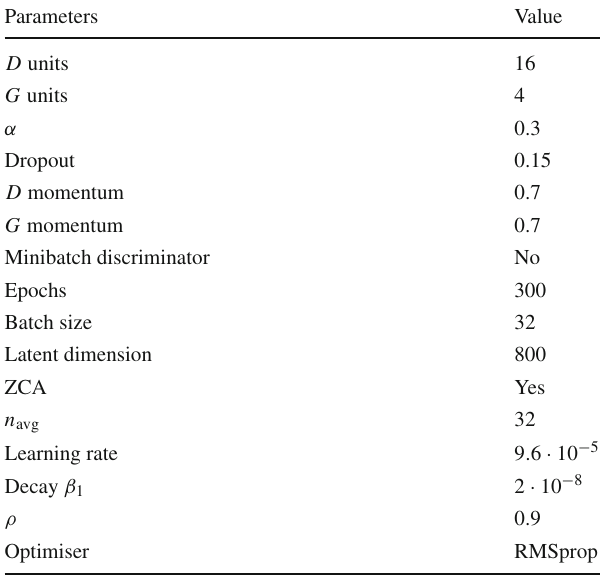
Fig. 14 A random selection of preprocessed input images (left), and of images generated with the VAE model (right). Axis and colour schemes are the same of Fig. 5 Table 4 Final parameters for the WGAN-GP model